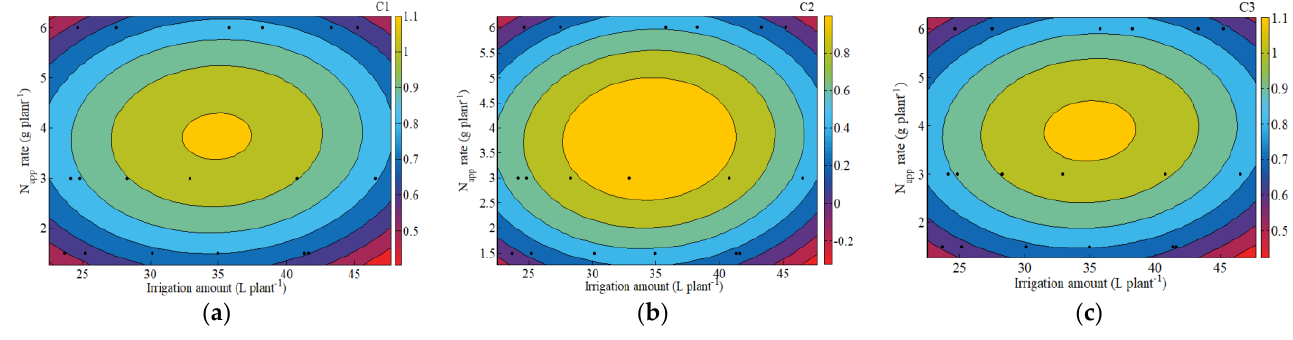
Figure 6. Relationship between the investments of irrigation amount and N app rate and the targets of C 1, C 2, and C 3 for green peppers; ( a ) was the addition combination, ( b ) was the multiplication combination, and ( c ) was the mean square root combination. N app means nitrogen application. Table 6. Relationship between the investments of irrigation amount and N app and the targets of C1, C2, and C3 for green peppers in 2019 and